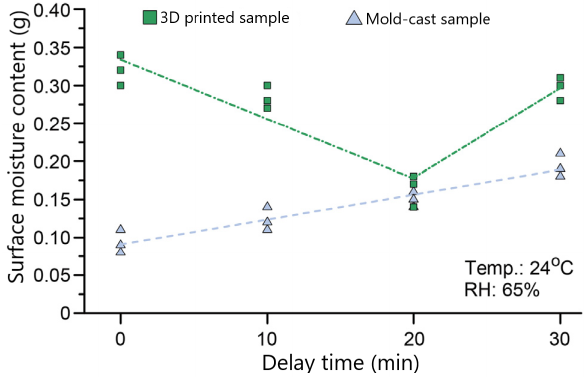
Figure 2. Surface moisture of printed and mold-cast concrete, measured by application of a paper towel (Sanjayan et al.,